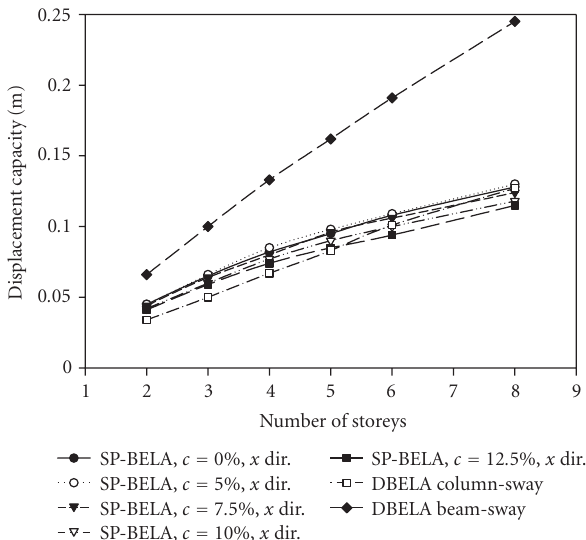
Figure 13: Mean yield displacement capacity versus number of storeys for the beam- and column-sway cases of DBELA compared with each of the SP-BELA design categories in the y